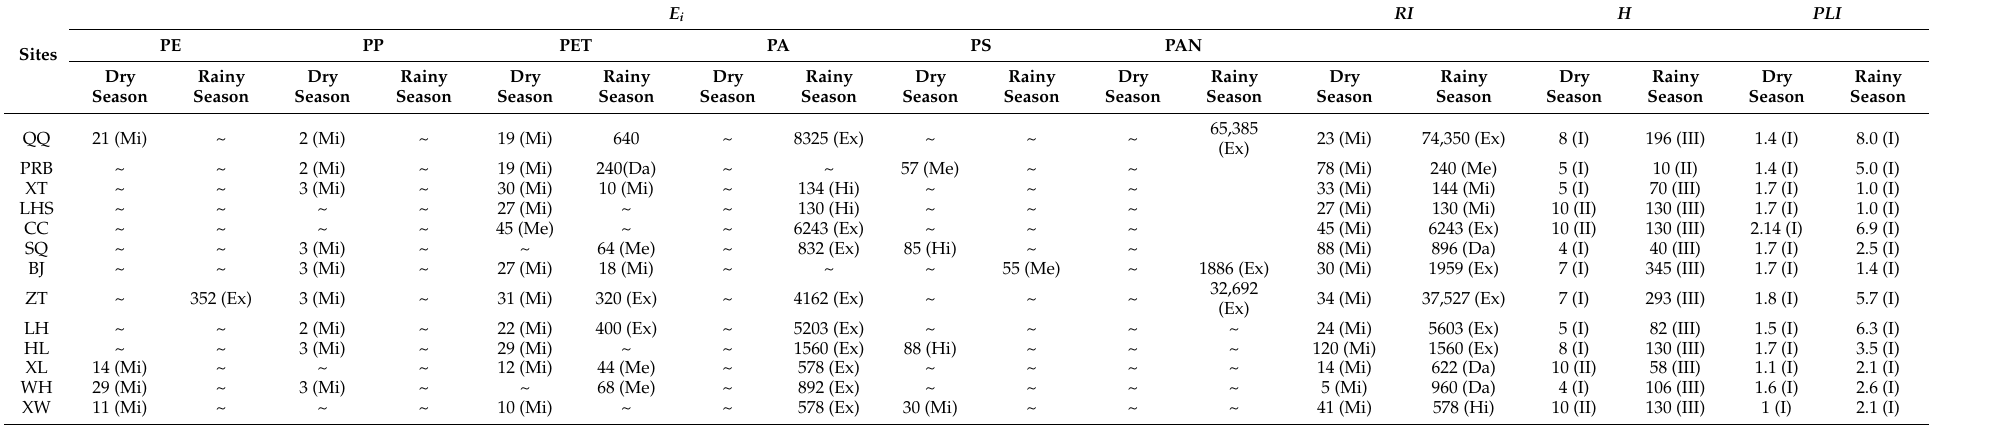
Table 2. Potential ecological risk assessment of microplastics in the Pearl River